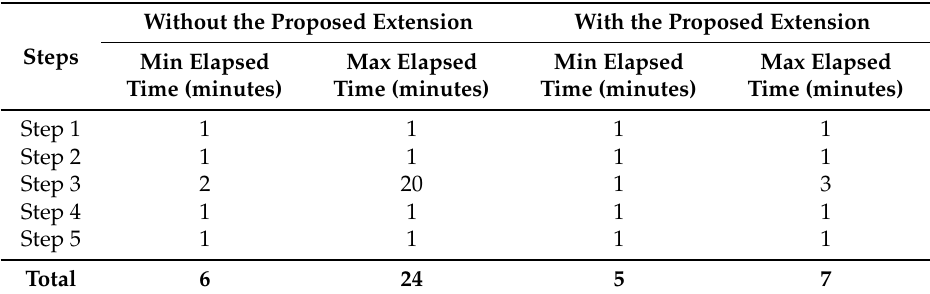
Table 2. Elapsed Times for Scenario 1—without and with the proposed